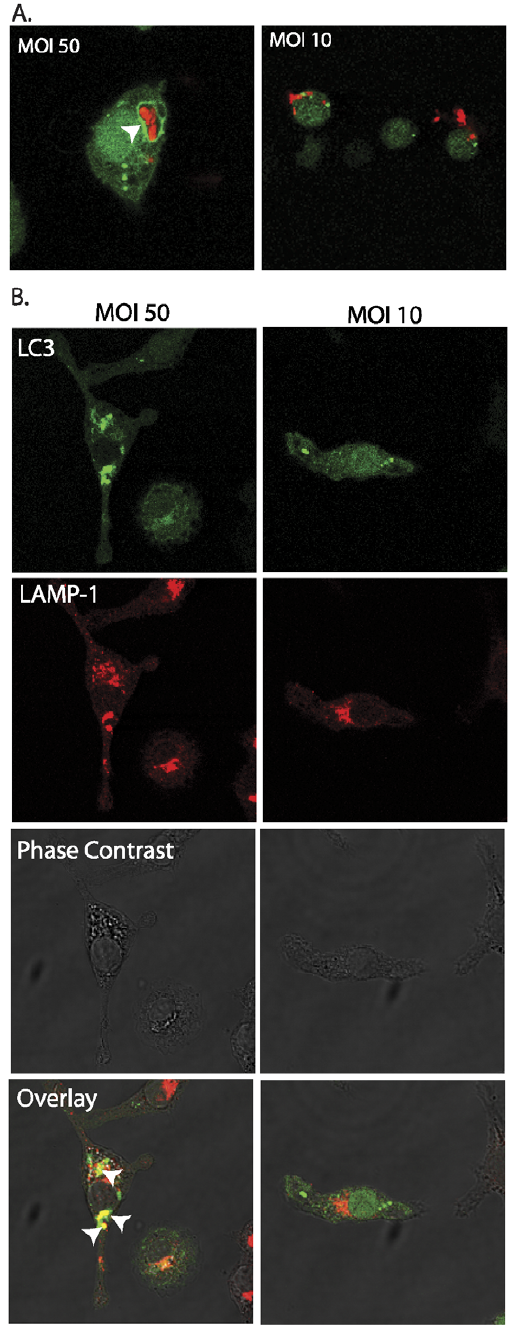
Figure 7. M.tb localizes to LC3-positive compartments. ( A ) GFP- LC3 expressing macrophages were infected with mCherry- M.tb (MOI 50 or 10, 6 h) and then fixed and observed by confocal microscopy. At high MOI there are GFP-LC3 rings surrounding ( arrowhead ) around mCherry- M.tb and co-localization indicated by yellow pixels ( arrow ) that are not seen in macrophages challenged at low MOI. ( B ) LAMP1 immunostaining of GFP-LC3 cell line macrophages infected with M.tb Edrman (MOI 50 or 10, 5 h) demonstrates co-localization of LC3 and lysosomal markers ( arrowheads ).